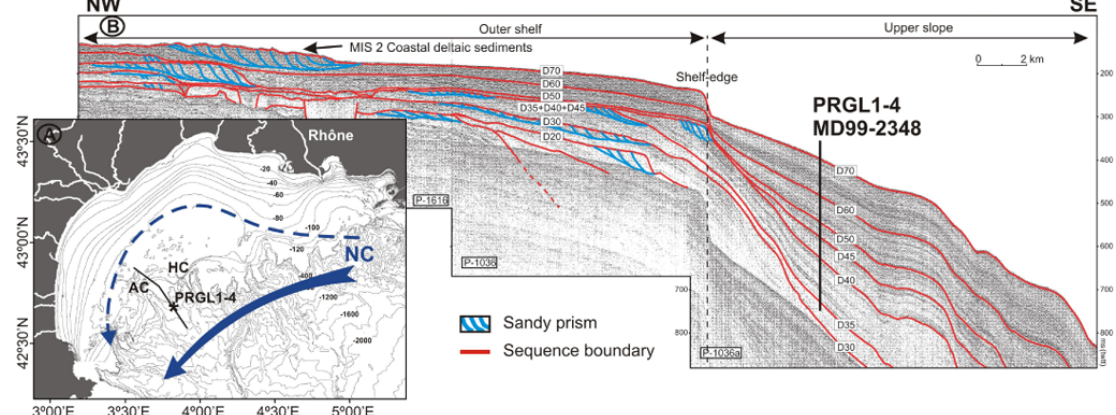
Fig. 1. (A) Bathymetric map of the Gulf of Lion with location of borehole PRGL1-4 in the interfluve separating Aude and H´erault submarine canyons, AC and HC, respectively. The dominant component of the general circulation is shown by the geostrophic Northern Current (NC), which flows southwestward along the slope and occasionally penetrates over the outer shelf, blue arrows. (B) Part of high-resolution seismic reflection profile P-1036a crossing the borehole location in a NW–SE direction across the outer shelf and upper slope (modified from Jouet, 2007). Stratigraphic sequences S1 to S5 delimited by main reflectors D35 to D70 marked as defined by Jouet (2007). Red reflectors show the main conformities separating RPUs while the blue ones correspond to sandy